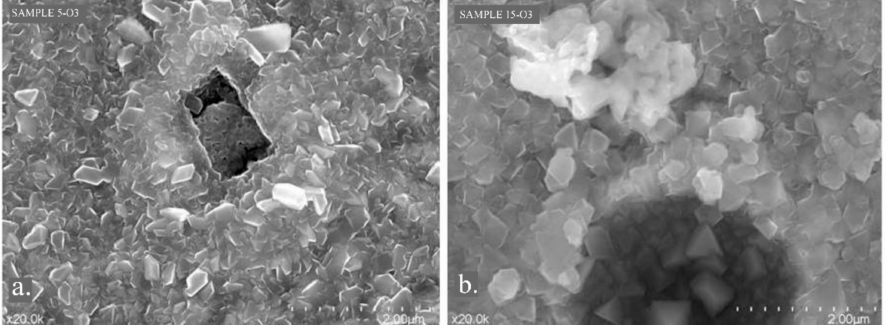
Figure 11. The defects at the surface of the oxide layers: ( a ) sample 5-O3; ( b ) sample 15-O3.